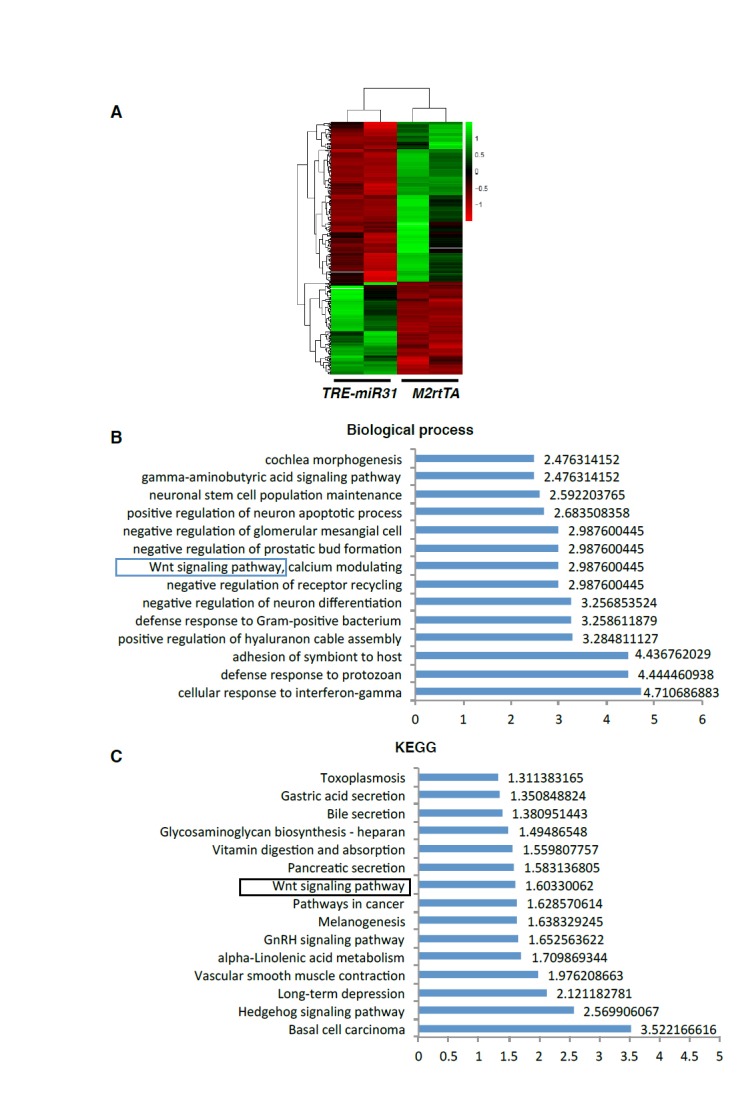
 Transcriptome profiling of miR-31 overexpressing intestines.